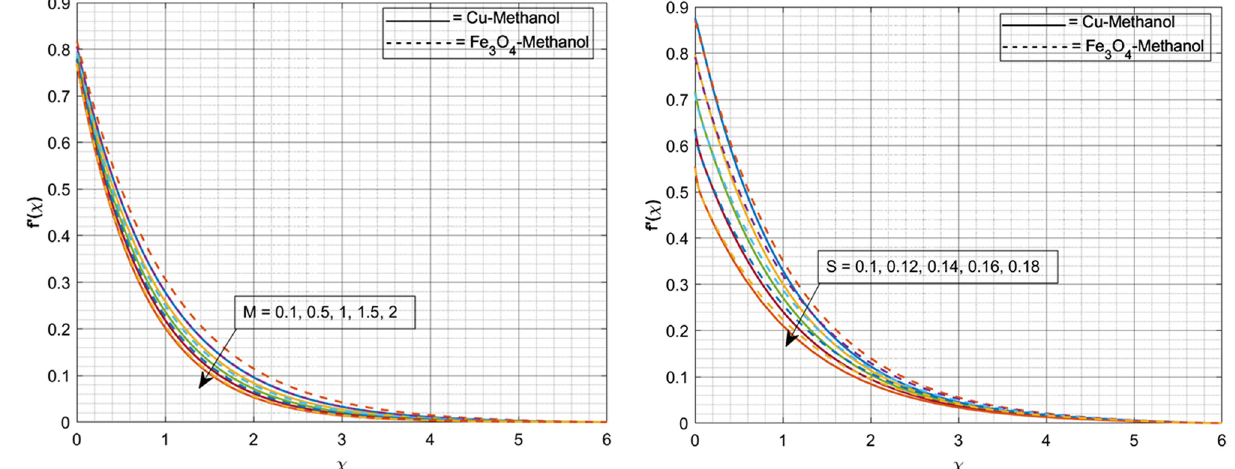
Figure 3: Sway of M on f ′ .